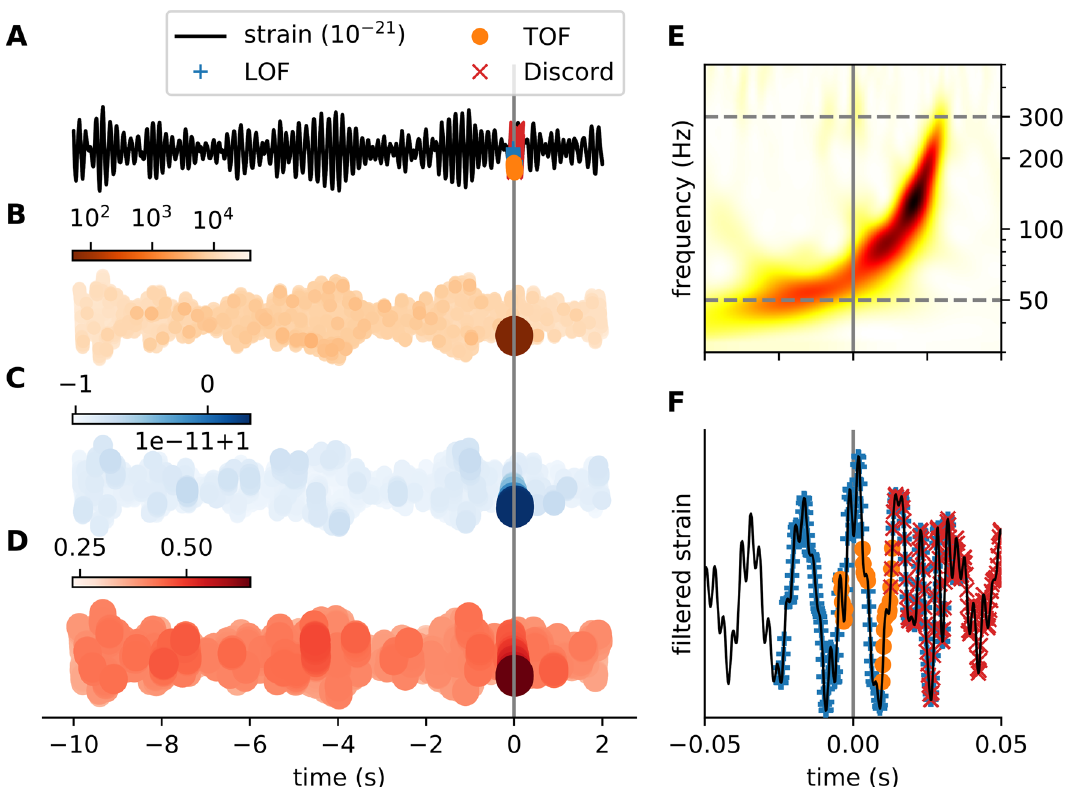
Figure 6. Detection of the GW150914 event on LIGO open data with TOF and LOF and discord. ( A ) Strain time series (black) from Hanford detector around GW150914 event (grey vertical line) with TOF (orange dots), LOF (blue plus) and discord (red x) detections. TOF score values ( B ), LOF scores ( C ) and matrix profile scores ( D ) are mapped to the time series (orange, blue and red colors respectively), the strongest colors show the detected event around 0 s. ( E ) The Q-transform of the event shows a rapidly increasing frequency bump in the power spectra right before the merger event (grey). The grey horizontal dashed lines show the lower (50 Hz) and upper (300 Hz) cutoff frequencies of the bandpass filter, which was applied on the time series as a preprocessing step before anomaly detection. ( F ) Filtered strain data at 0.1 s neighborhood around the event. TOF, LOF, and discord detection algorithms detected the merger event with different sensitivity. LOF detected more points of the event, while TOF found the period which has the highest power in the power spectra, and a discord was detected at the end of the event. ( E TOF = 6 , τ TOF = 1.953 ms, k TOF = 12 , M TOF = 146.484 ms, w = 7 ; E LOF = 11 , τ LOF = 1.953 ms, k LOF = 100 , threshold = 0.5 %, M discord = 146.484 ms